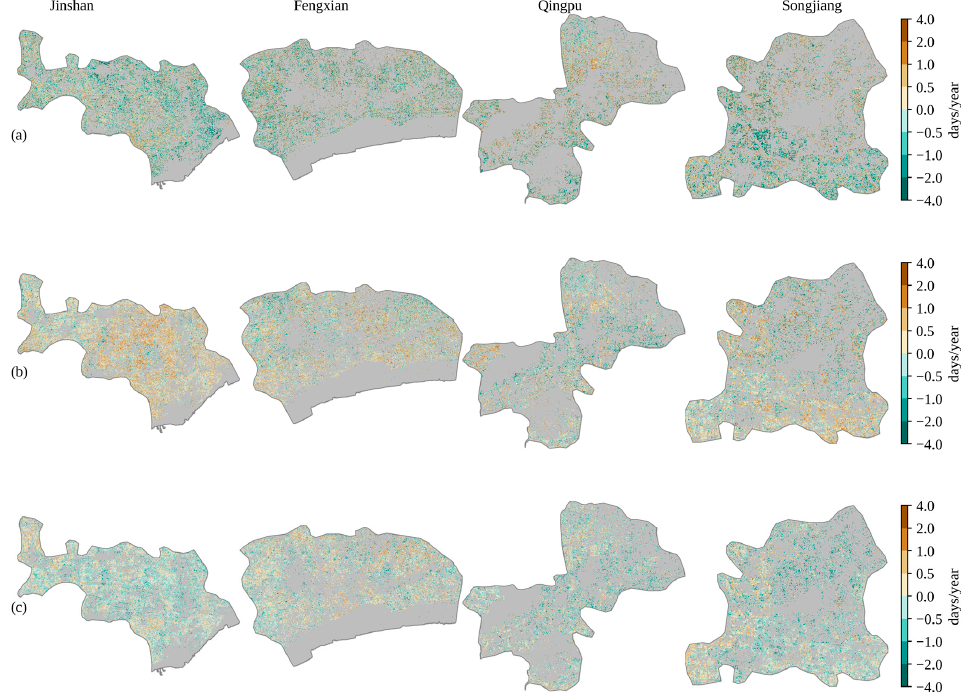
Figure 5. Maps of interannual trends of phenological metrics from 1993 to 2009 in the four counties of Shanghai. Each column in the figure indicates one of the four counties. ( a ) linear trends of peak of first cropping cycle (POS1). ( b ) linear trends of start of second cropping cycle (SOS2). ( c ) linear trends of peak of second cropping cycle (POS2). Gray regions represent missing data, non-crop areas, and non-significant regions ( p -value >